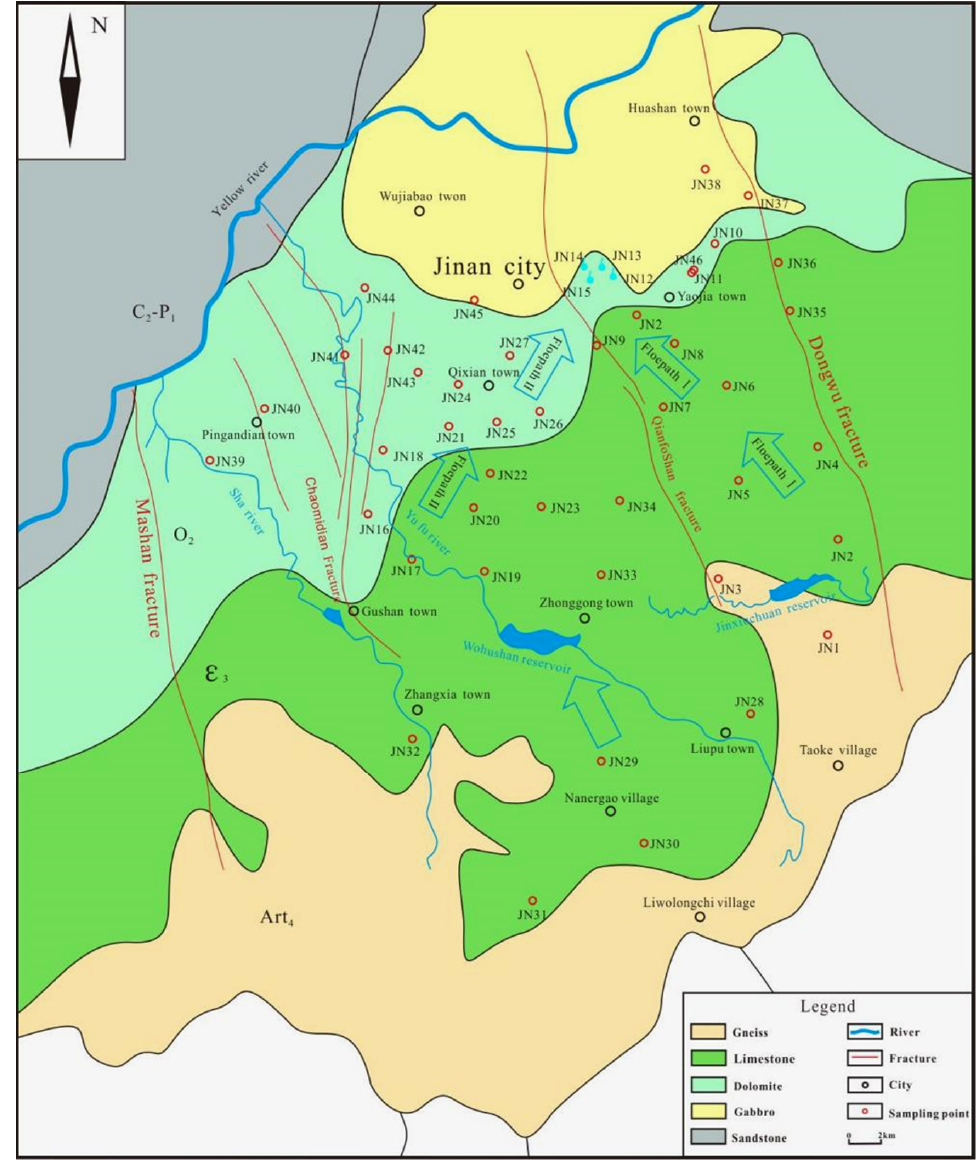
Figure 1. A simple geological map and sampling sites in Baotu karst water system.